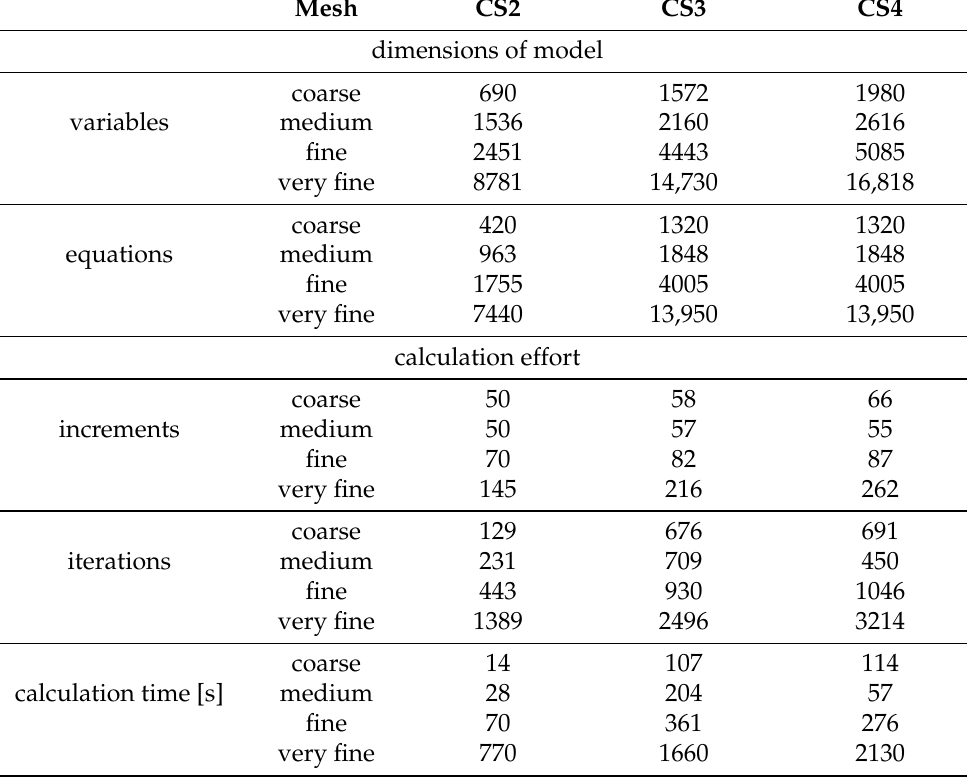
Table 3. Models dimensions and calculation times for